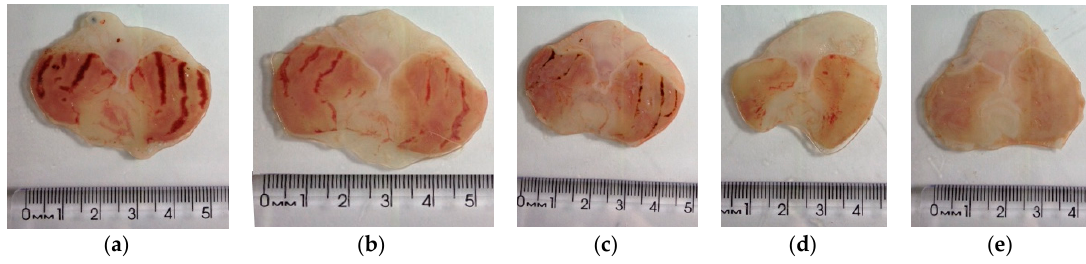
Figure 4. Typical photograph of the gastroprotective effect of aqueous extract of X. americana (XaAE) stem bark on absolute ethanol-induced (99%, 1 mL, orally) gastric lesions in rats. ( a ) lesioned control (NaCl 0.9%, 10 mL/kg, orally); ( b ) pantoprazole (40 mg/kg, orally); ( c – e ) XaAE (100, 200 and 400 mg/kg, orally, respectively). Molecules 2018 , 23 , 112